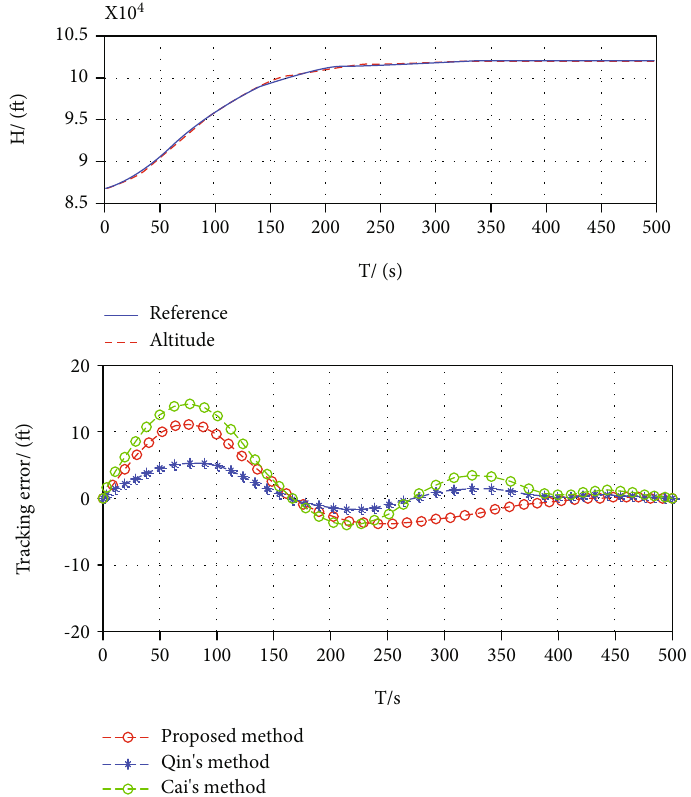
Figure 6: Altitude tracking performance and tracking error.